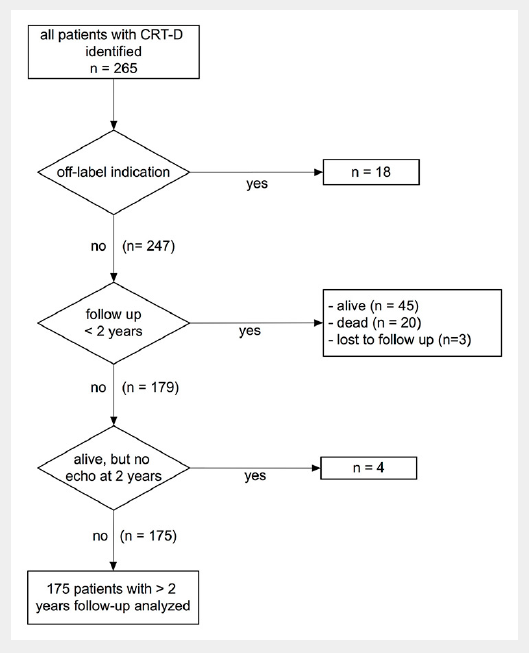
Changes in ejection fraction during long-term follow-up in patients with improvement to >40% (boxes indicate the interquartile range, whiskers 1.5-fold the length of the